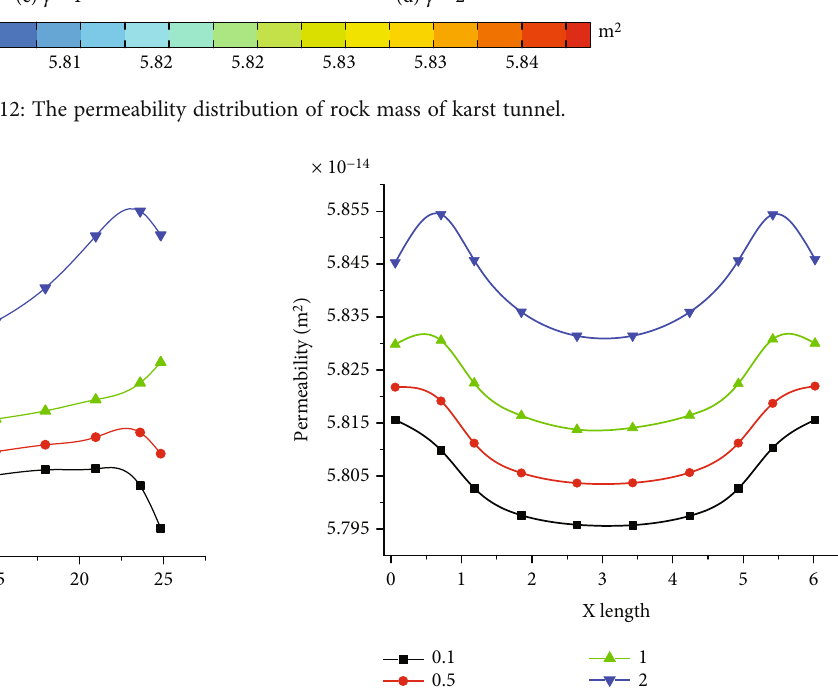
Figure 14: The permeability distribution at di ff erent locations in the k - j line.